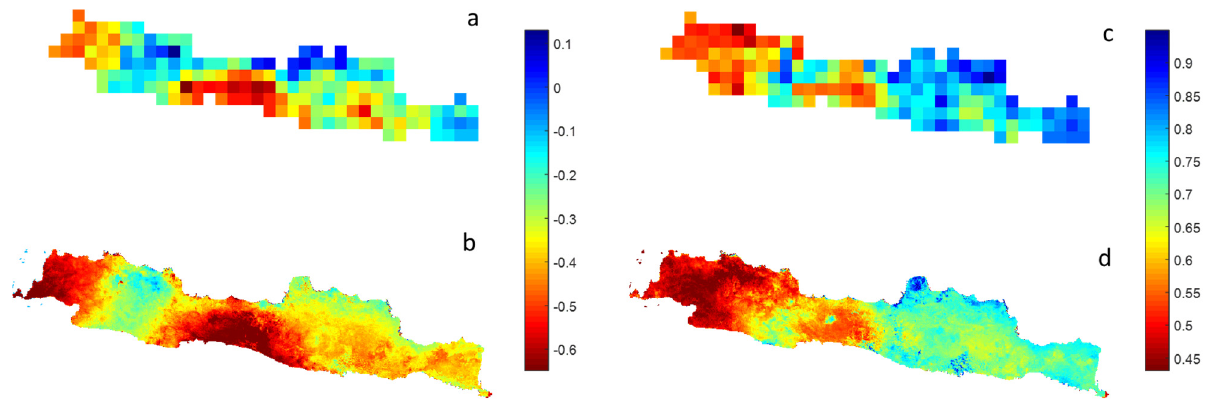
Figure 6. Average ( a , b ) and standard derivation ( c , d ) maps of SPI 6 in 2018–2019 when compared with original data ( a , c ) and spatial downscaling results ( b , d ).